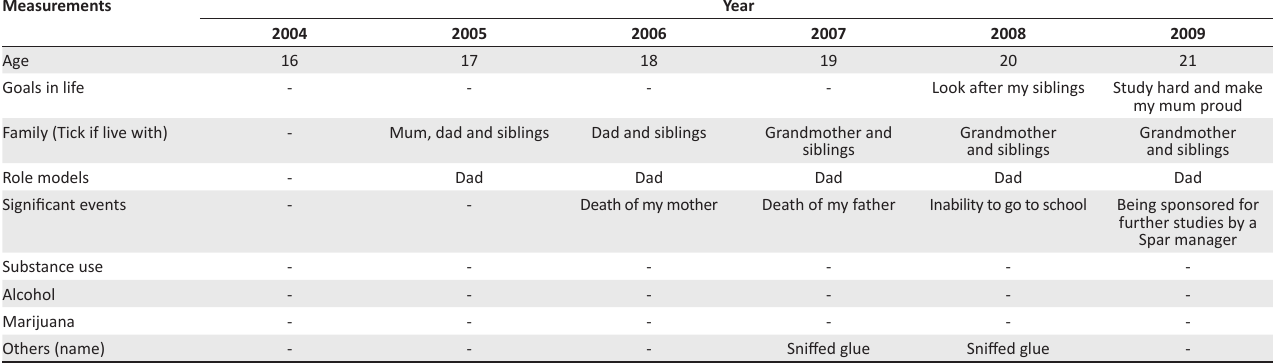
TABLE 2a: A sample of the event history calendar completed by a participant. Measurements